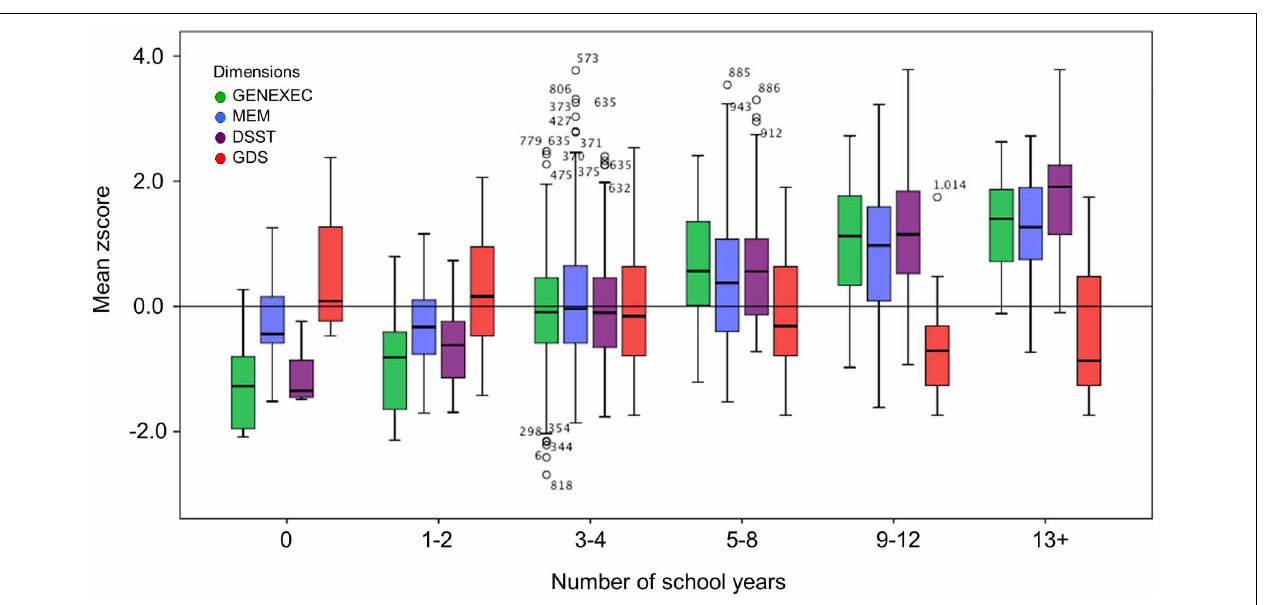
groups. We found that education was the main factor